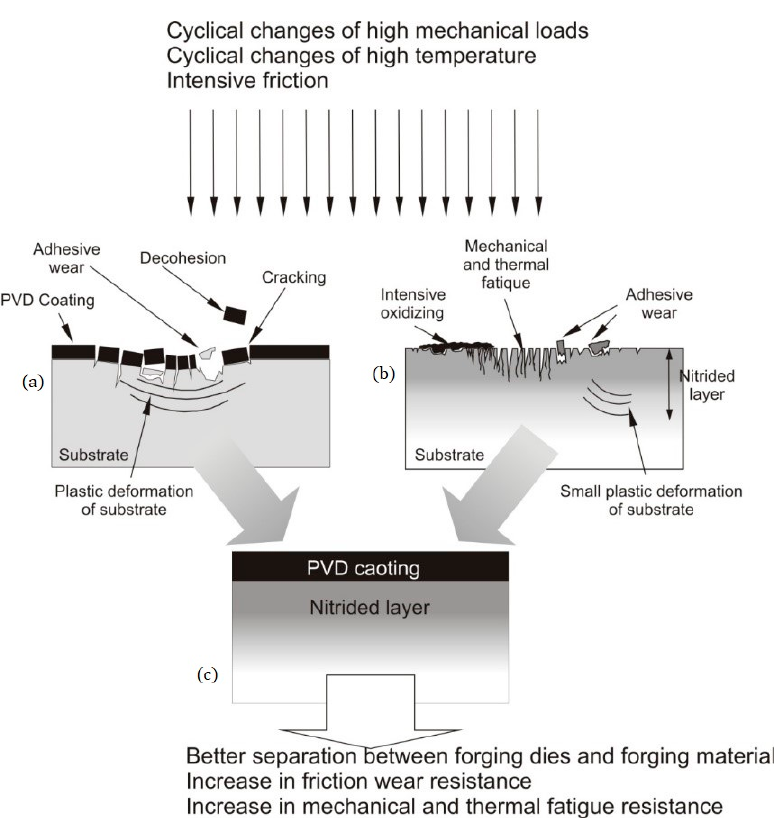
Figure 4. The destruction process scheme for the hybrid layer for the nitrided layer/PVD coating type: ( a ) heat-treated steel + PVD coating, ( b ) heat-treated steel + nitriding, ( c ) heat-treated steel + nitriding + PVD coating. Reprinted from permission from [15,56]. Copyright 2007 The Ł ukasiewicz